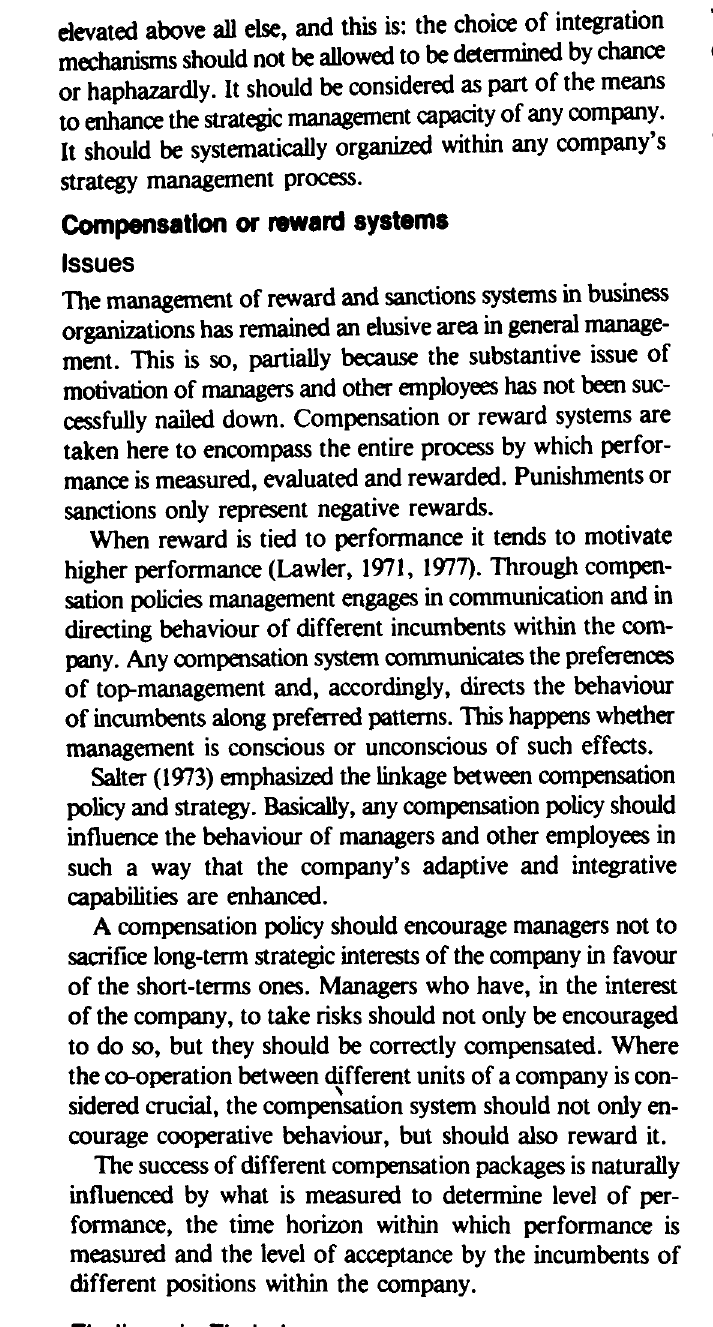
Table 10d Levels of bonus schemes